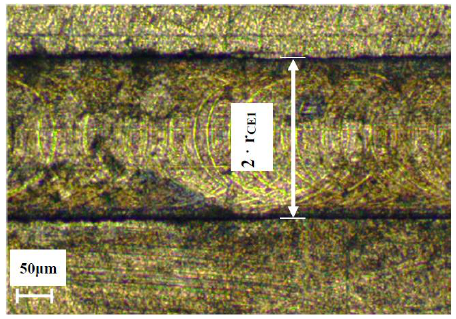
Figure 4. Experimental measurement of the rotational radius of the first cutting edge (r CE1 ) from channel width.